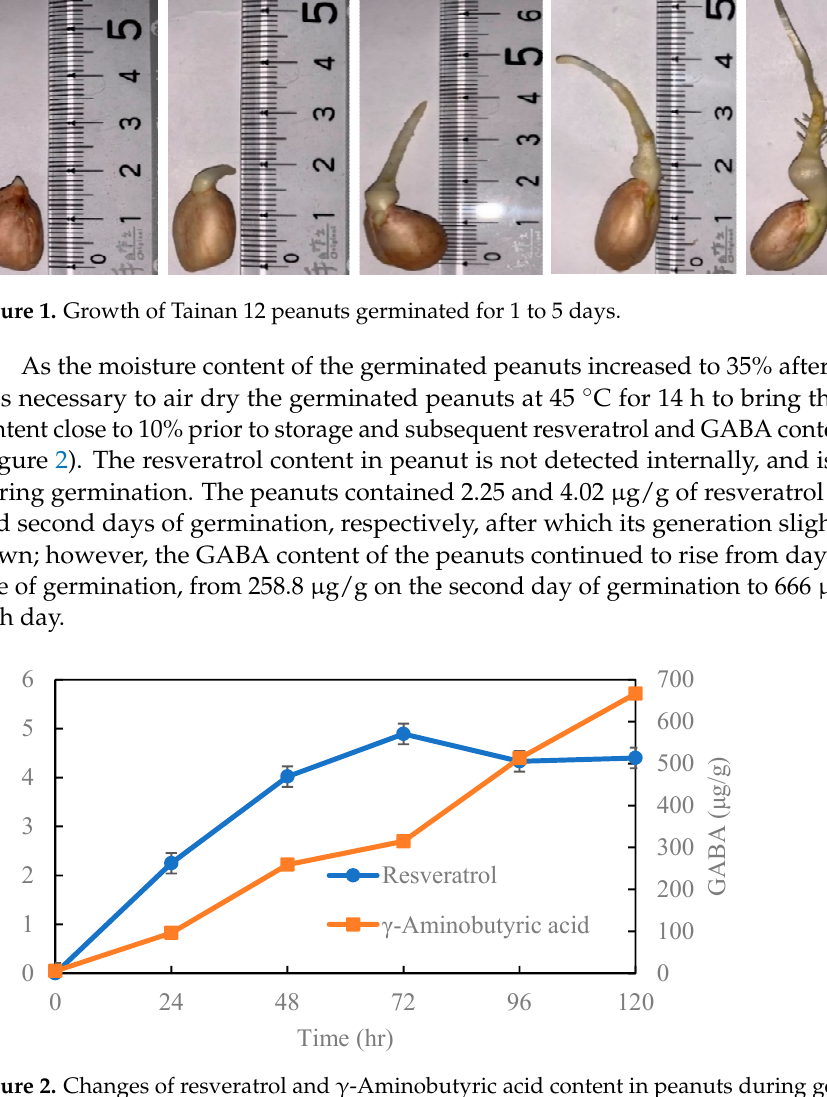
Figure 2. Changes of resveratrol and γ -Aminobutyric acid content in peanuts during germination.